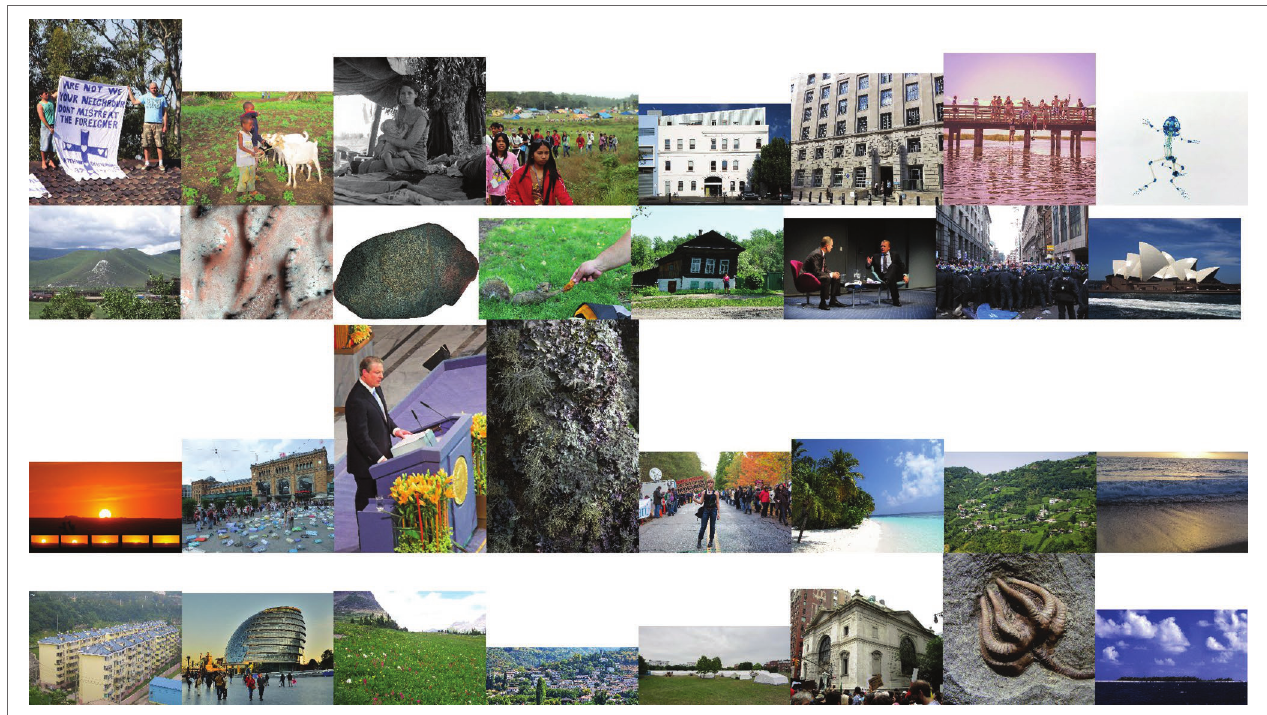
FIGURE 4 | The 32 images rated lowest in relevance to climate change, read from bottom right to top left.